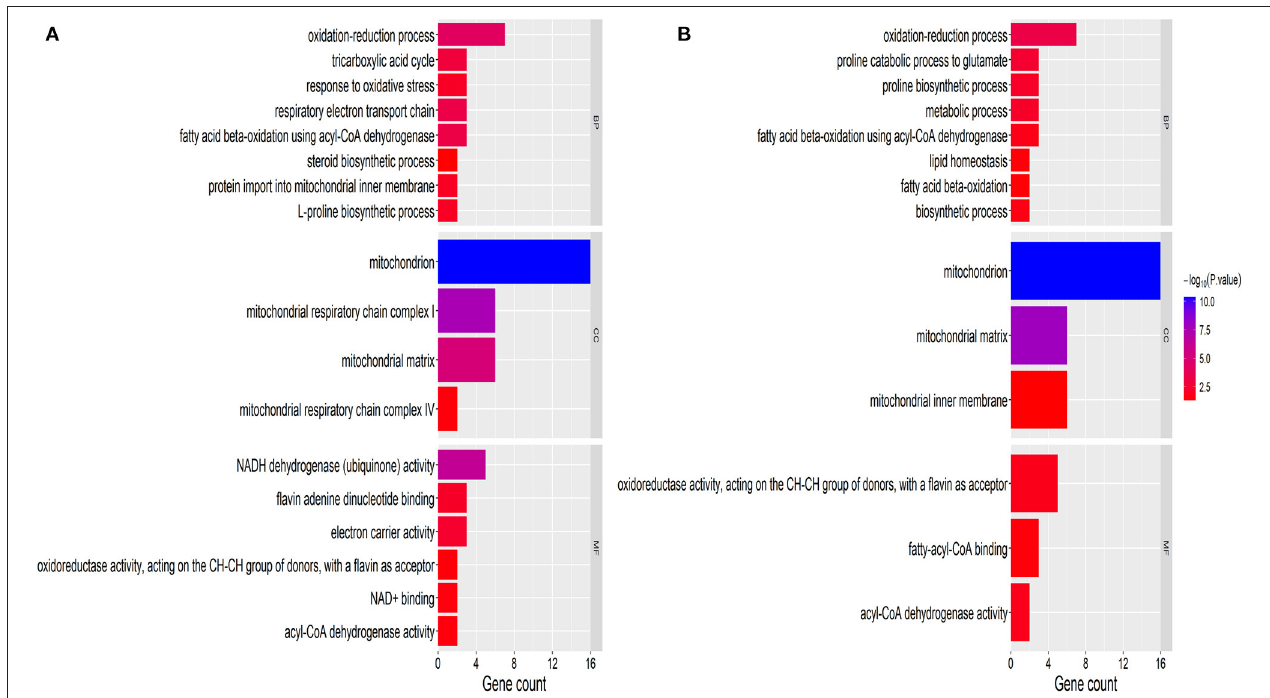
FIGURE 2 | GO classification of DAPs. (A) Upregulated proteins. (B) Downregulated proteins. The x-axis represents GO terms. The y-axis represents the number of enriched proteins within each primary category. MF, molecular function; BP, biological process; and CC, cellular component.